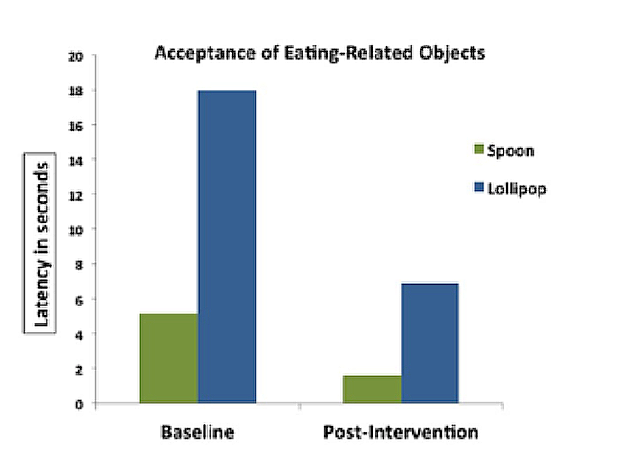
Table 5. Responses to Modified EAT-10 (Belafksy et al., 2008) at Three Time